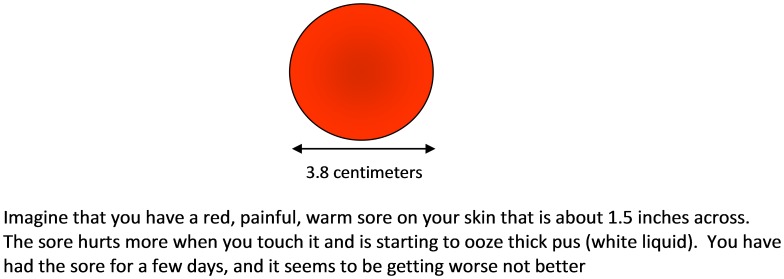
Description of Draining Sore Vignette.